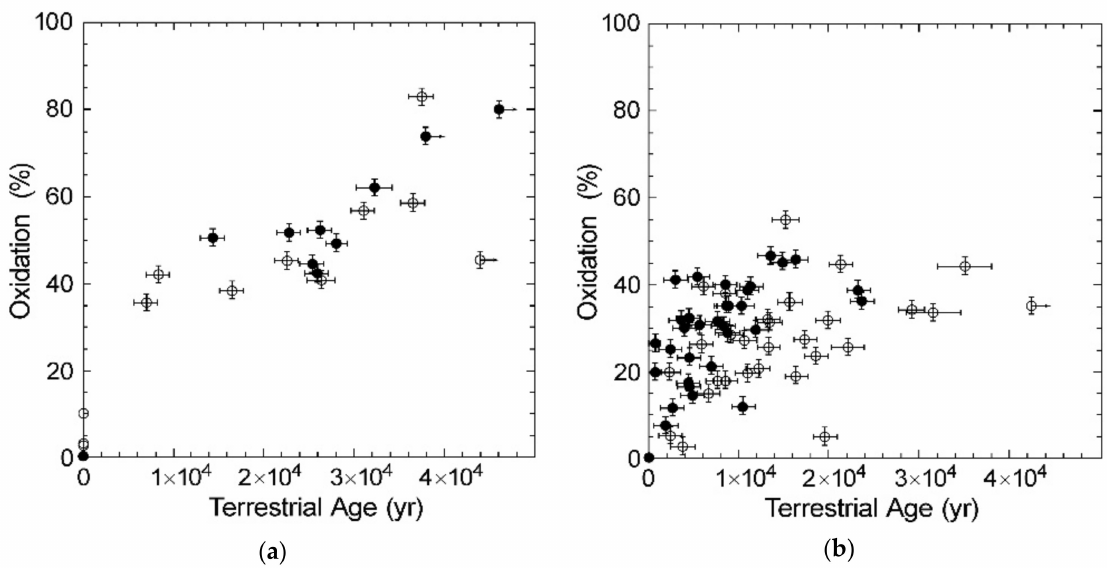
Figure 49. Correlation between oxidation (the total relative area of ferric components deduced from the Mössbauer spectroscopy) and terrestrial age determined using 14 C for H ( • ) and L/LL ( County ( a ) and Sahara Desert ( b ). Adapted from Reference